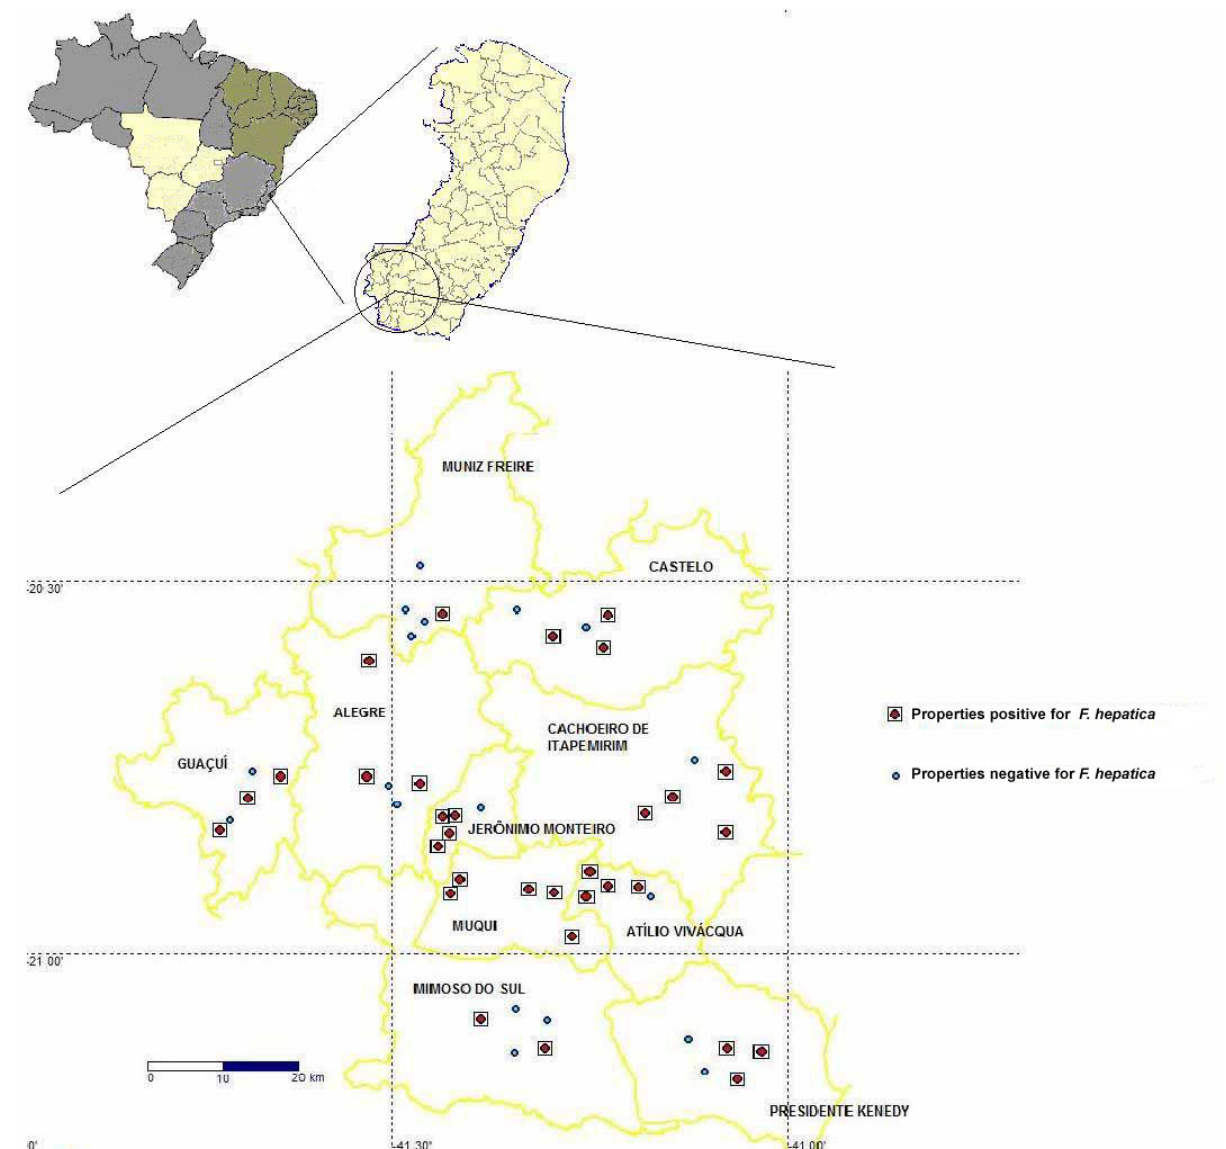
Figure 1. Schematic representation of the rural properties in ten cities of the south of Espírito Santo state,